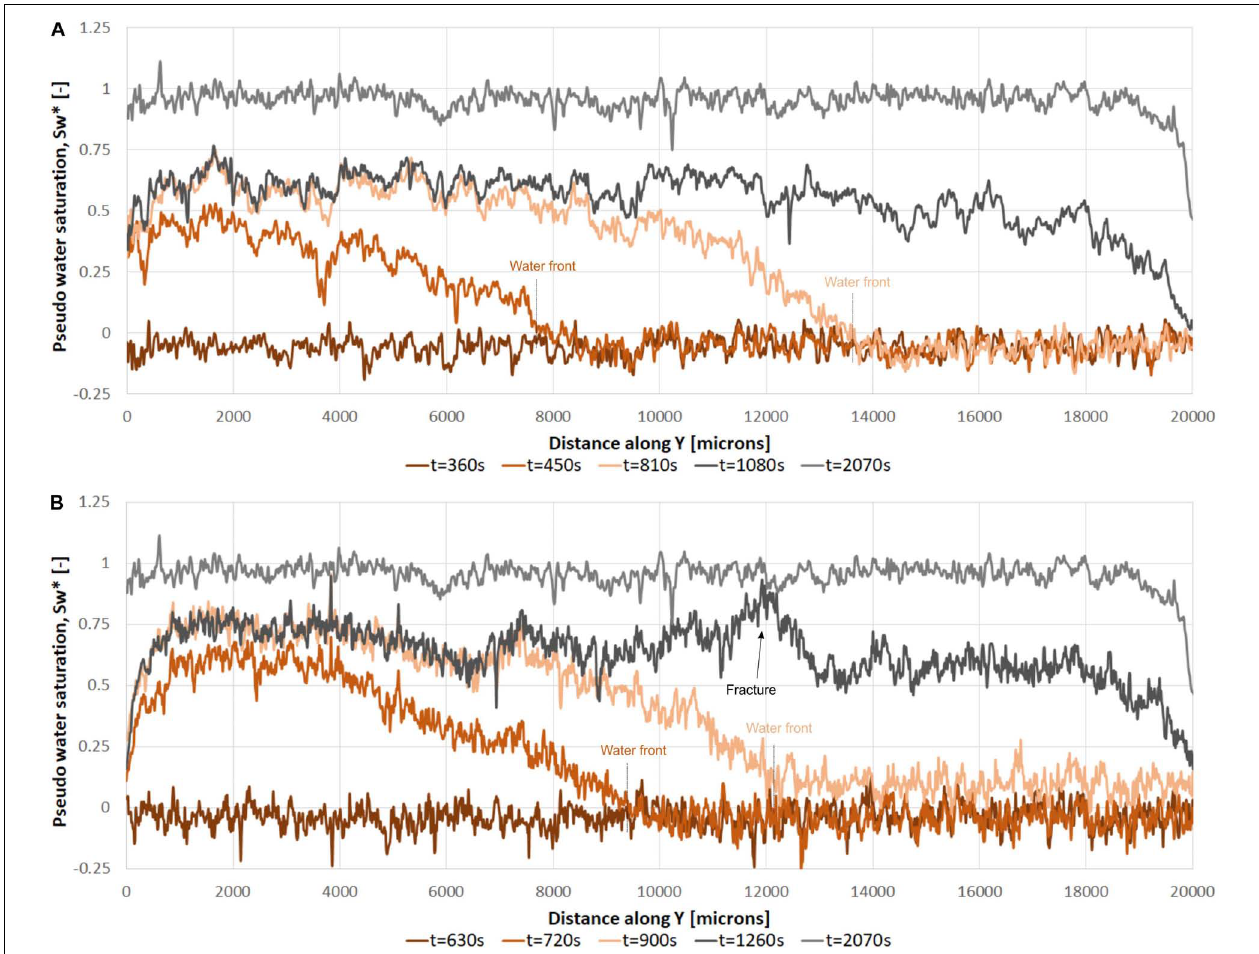
FIGURE 5 | Longitudinal profiles indicating the migration of the flow front and the relative pseudo saturation of the (A) Favignana grainstones, and (B) Orfento grainstones samples, indicating and anomalous increase of the saturation due to fractures ( t = 1260 s).